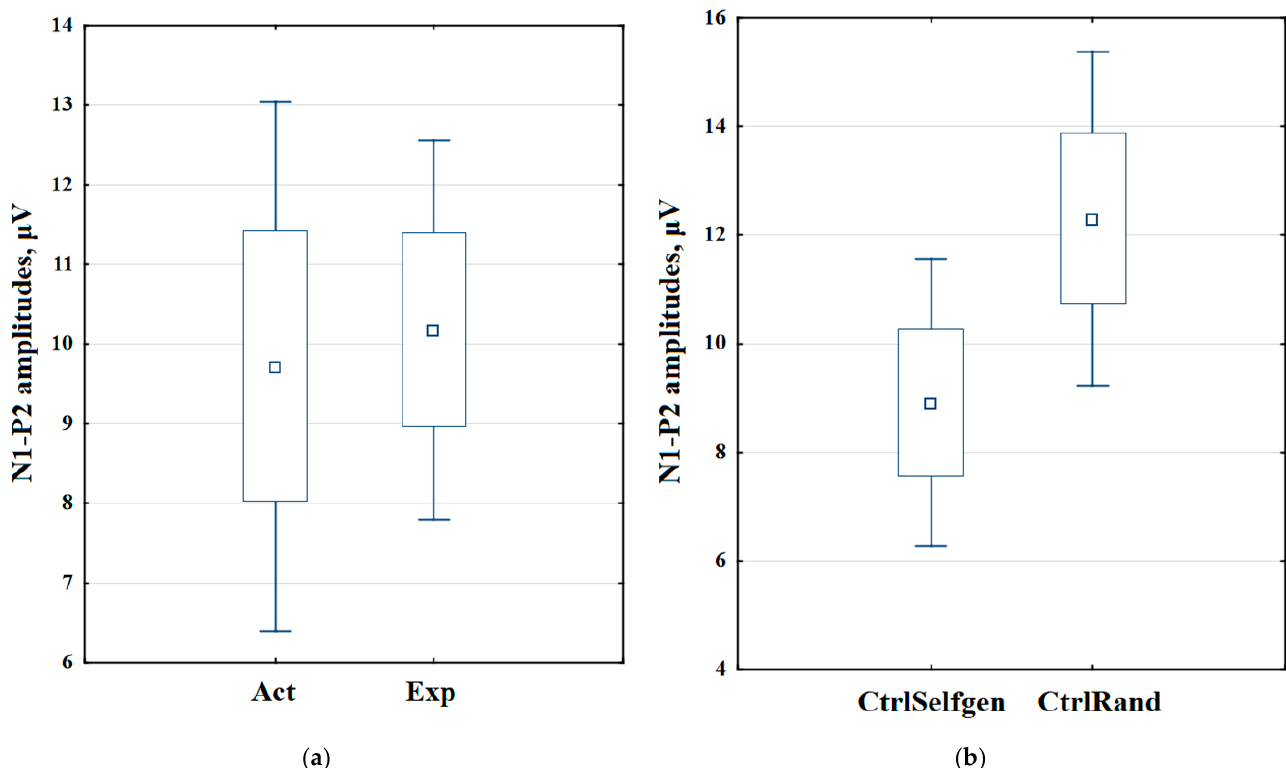
Figure 6. Box plots of N1-P2 inter-peak amplitude in the auditory ERP in different conditions. ( a ) In the Act and Exp conditions; ( b ) in the CtrlSelfgen and CtrlRand conditions.